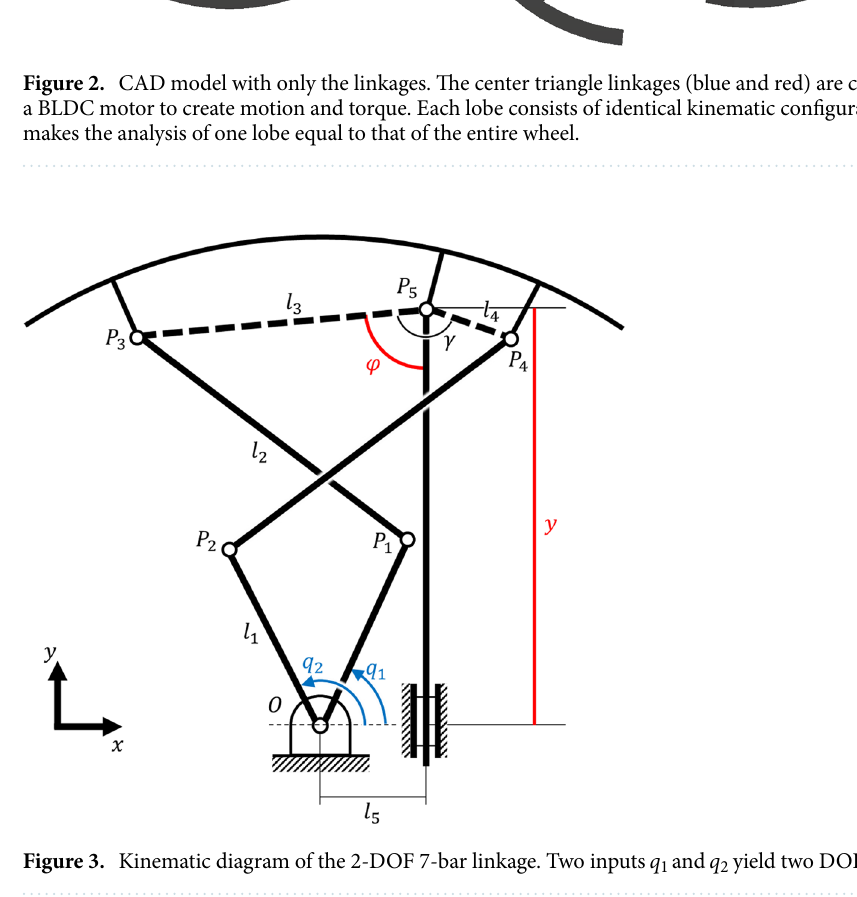
using the two unknowns ϕ and y .